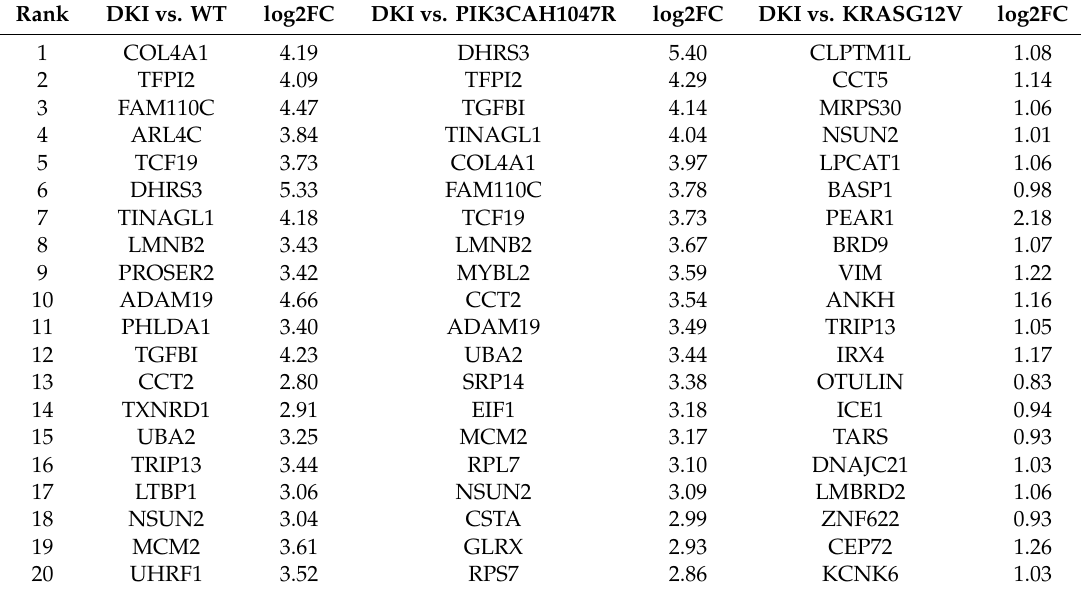
Table 1. Top 20 di ff erentially expressed genes (upregulated), DKI vs. WT and single mutant cells. Log2FC sorted by p value.